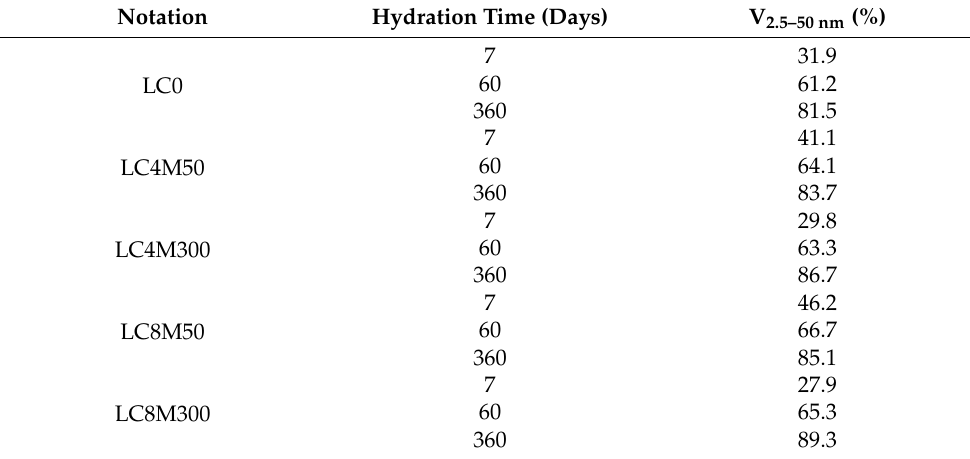
Table 7. V 2.5–50 nm of LHP concrete added with MgO.